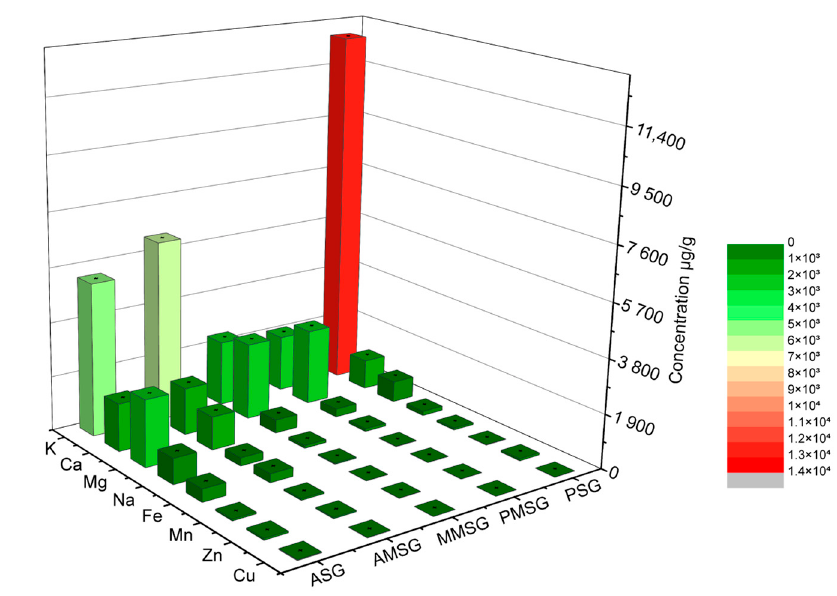
Figure 1. Distribution of metal ions in silk glands during the wandering stage. (ASG: anterior silk glands; AMSG: anterior part of middle silk glands; MMSG: middle part of middle silk glands; PMSG: posterior part of middle silk glands; PSG: posterior silk glands. Error bars show SD.)